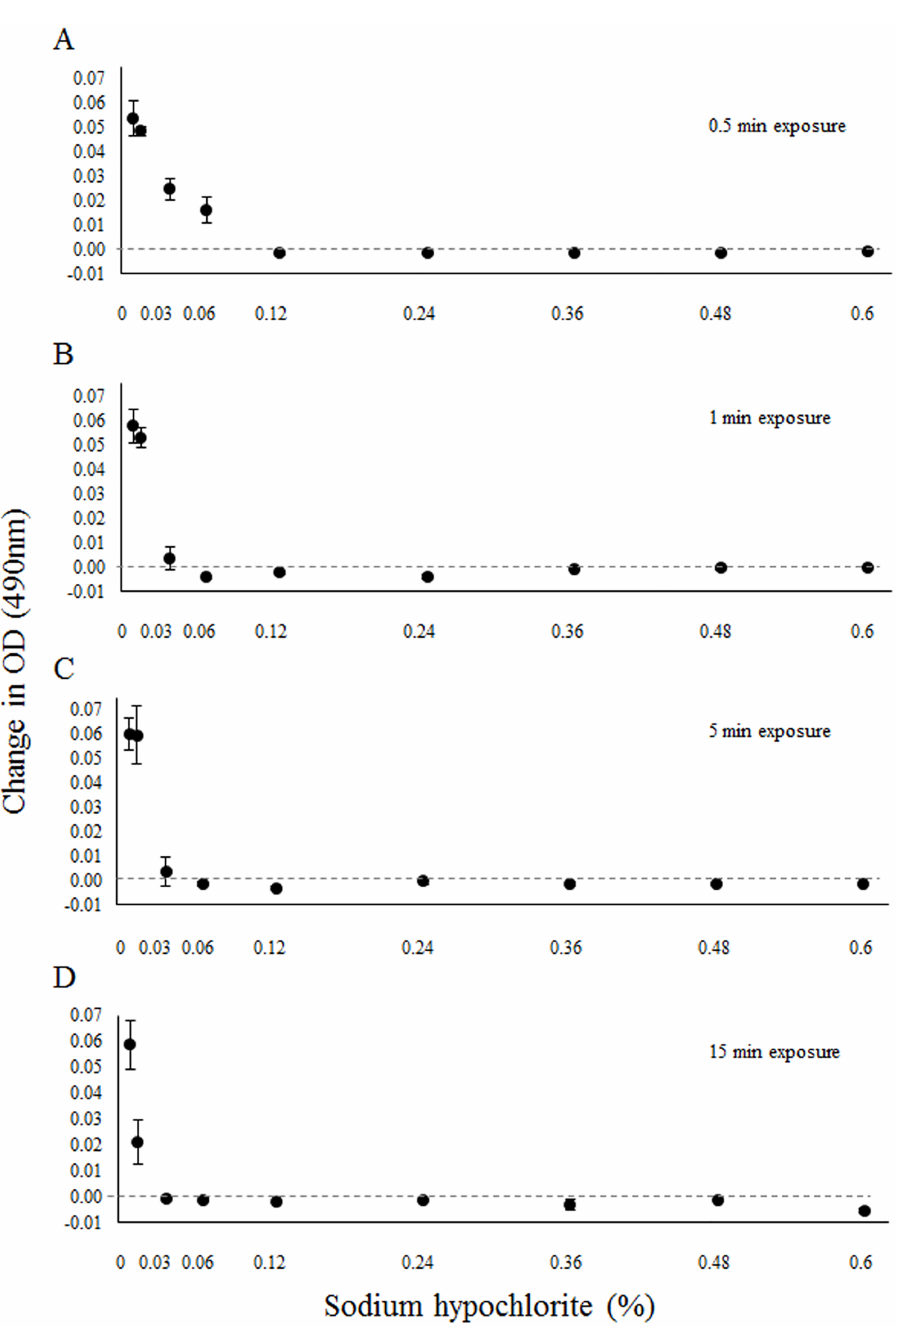
Fig 1. The effect of sodium hypochlorite on the growth of Batrachochytrium dendrobatidis (Bd). Changein optical density (OD) of Bd four days after exposureto variousconcentrations of sodium hypochlorite for (A) 0.5 min, (B) 1 min, (C) 5 min, and (D) 15 min. Error bars represent standard error.